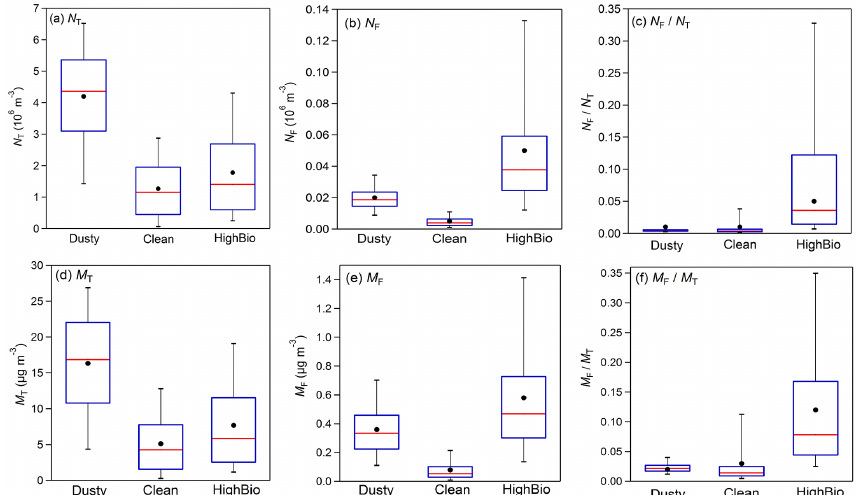
Figure 7. Statistical distribution of integrated ( ∼ 1–20µm) FBAP and TAP number and mass contribution of N F to N T , and M F to M T averaged over each distinct focus period (dusty, clean, and high bio; please refer to the text for definitions related to each focus period) measurements carried out at Munnar as box whisker plots: (a) TAP number concentration ( N T ) , (b) FBAP number concentration ( N F ) , (c) contribution of FBAP number concentration to TAP number concentration ( N F /N T ) , (d) TAP mass concentration ( M T ) , (e) FBAP mass concentration ( M F ) , and contribution of FBAP mass concentration to TAP mass concentration ( M T /M F ) .